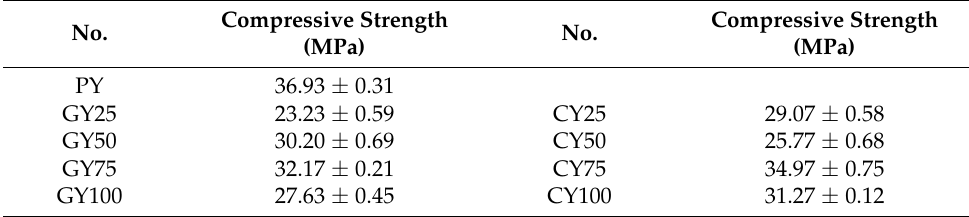
Table 6. Compressive strength of grouted steel ball concrete.